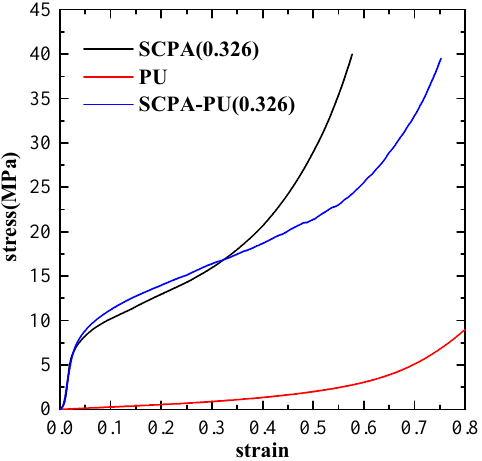
Figure 4. Compressive stress-strain curves of SCPA, PU and SCPA-PU composites.